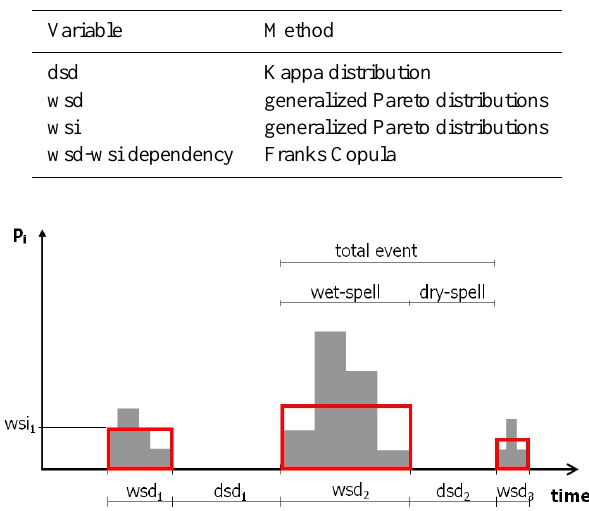
Fig. 2. Alternating Renewal Model (wsd-wet spell duration, dsd-dry spell duration, wsi-wet spell